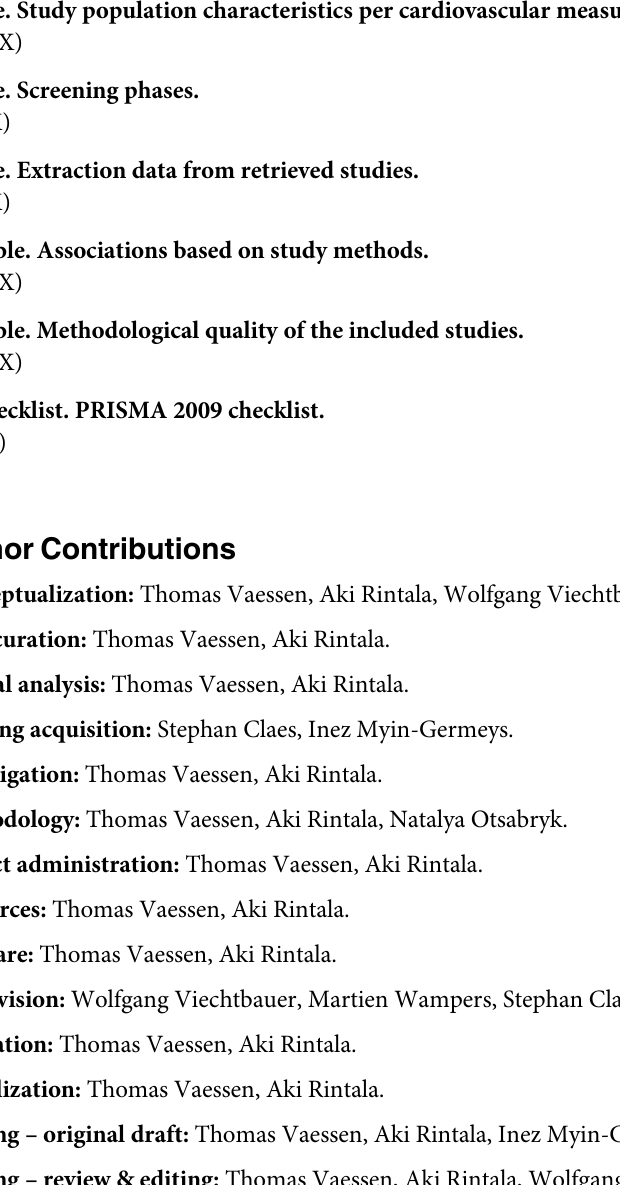
S1 Table. Associations based on study methods. S2 Table. Methodological quality of the included